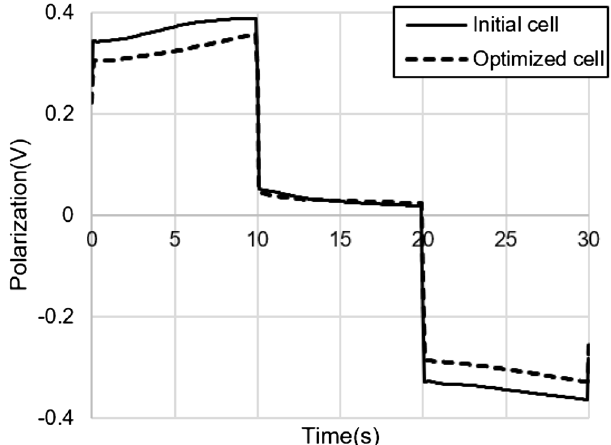
Figure 9. Polarization of initial cell and optimized cell in HPPC